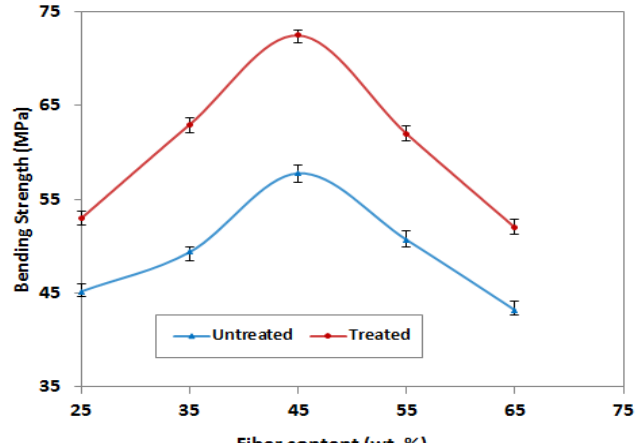
Figure 6: Comparative bending strength of the resultant composites with respect to fiber loading.